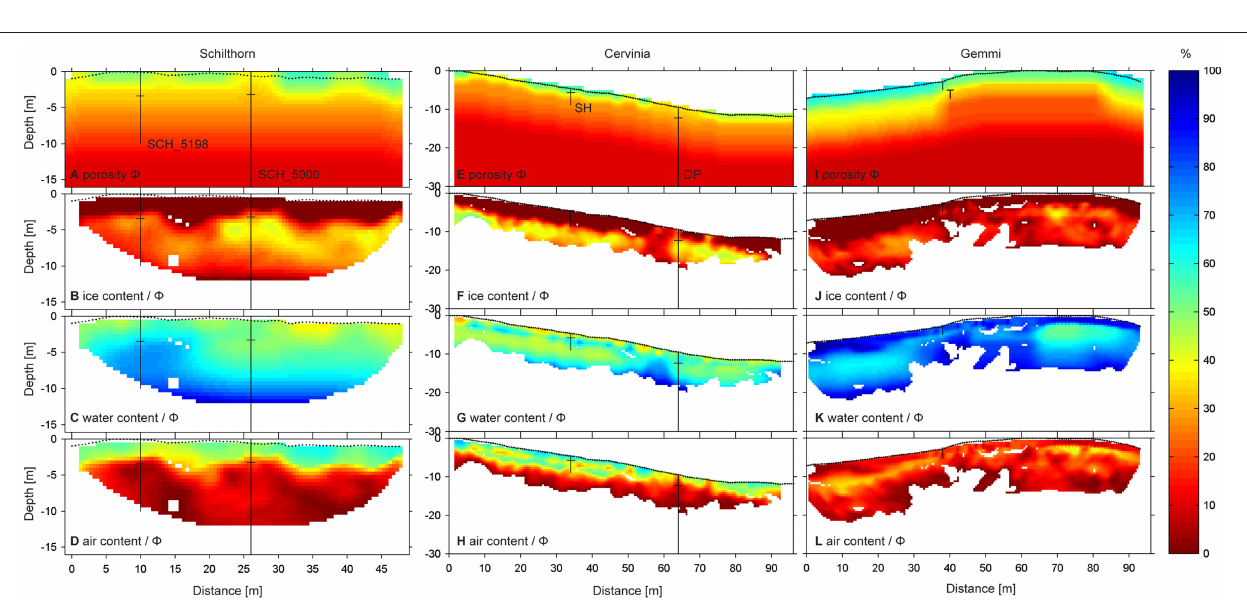
FIGURE 6 | Inverted specific resistivities (A,D,G) and p-wave velocities (B,E,H) for Schilthorn, Cervinia, and Gemmi. Note the different resistivity color scale at Schilthorn. The porosity models (C,F,I) are computed using a 3PM-dependent gradient [see Methods Section Four-phase model (4PM)]. Black lines indicate borehole positions, and dotted lines indicate the maximum depth of the 3PM-derived porosity.